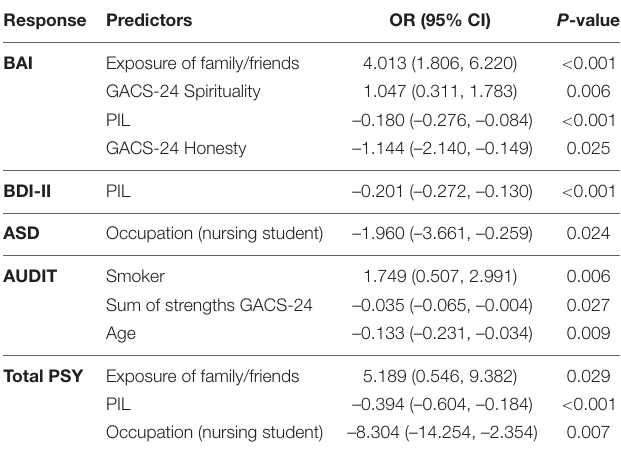
TABLE 4 | Significant odds ratios of linear regression models predicting the presence of